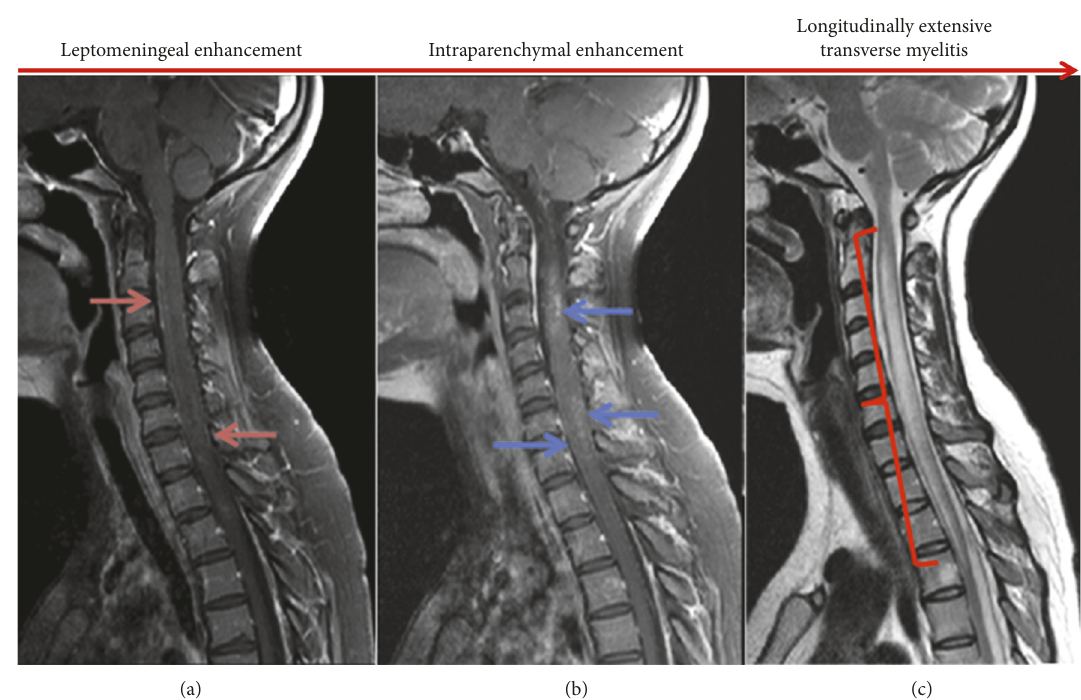
Figure 1: Spinal cord MRI. Sagittal gadolinium-enhanced T1-weighted images with fat saturation showing linear leptomeningeal thickening and enhancement (a) and intramedullary parenchymal patchy enhancement (b), correlating with diffuse T2-weighted hyperintense signal increase extending from C2 to Th3